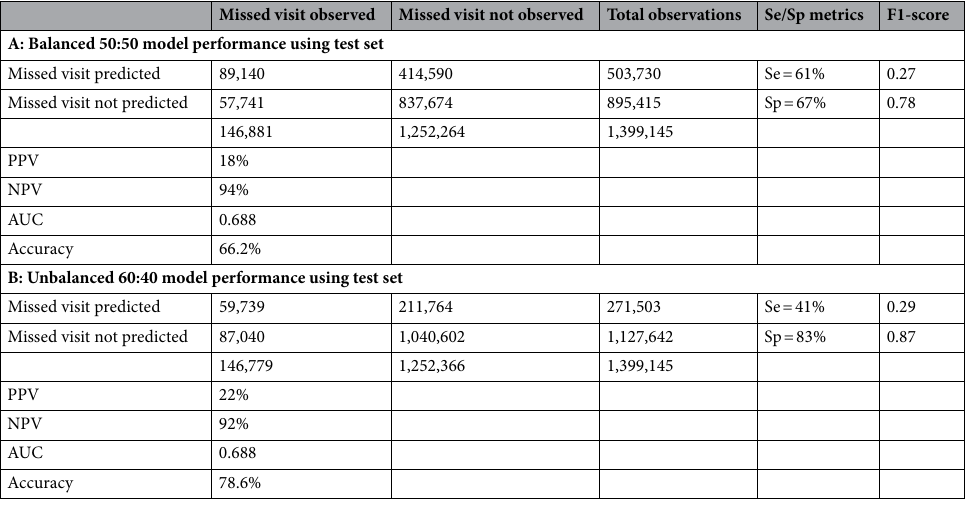
Table 2. Late visit model metrics based on (A) balanced and (B) unbalanced training sets. The F1 score is the harmonic mean of sensitivity and specificity such that 1.0 is the best score. Accuracy is the number of correct predictions out of the total number of predictions over the test set observations. Se = sensitivity; Sp = specificity; PPV = positive predictive value; NPV = negative predictive